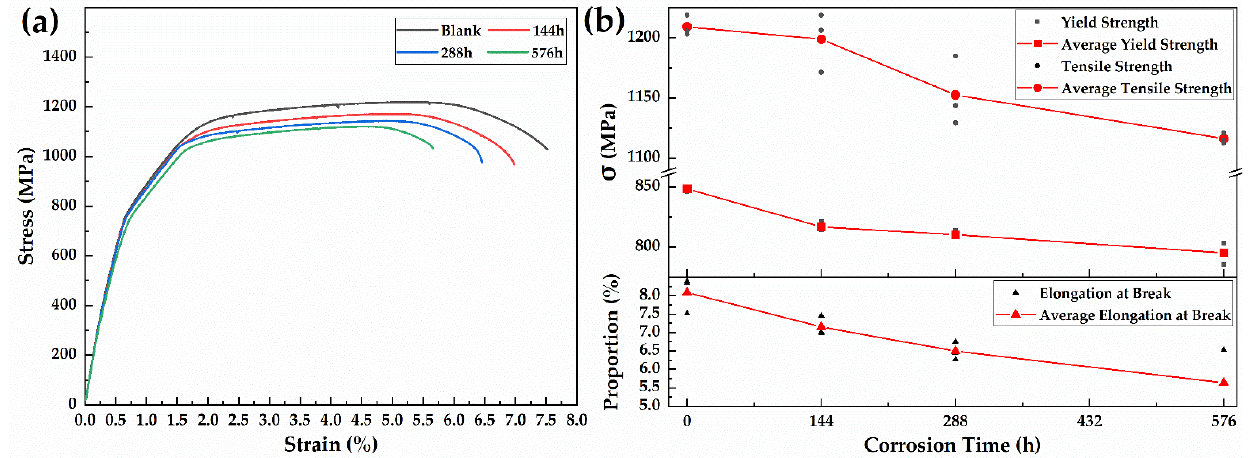
Figure 8. Stress–strain curve ( a ) and mechanical property parameters ( b ) of 30CrMnSiA steel after the 576-h alternate immersion test.